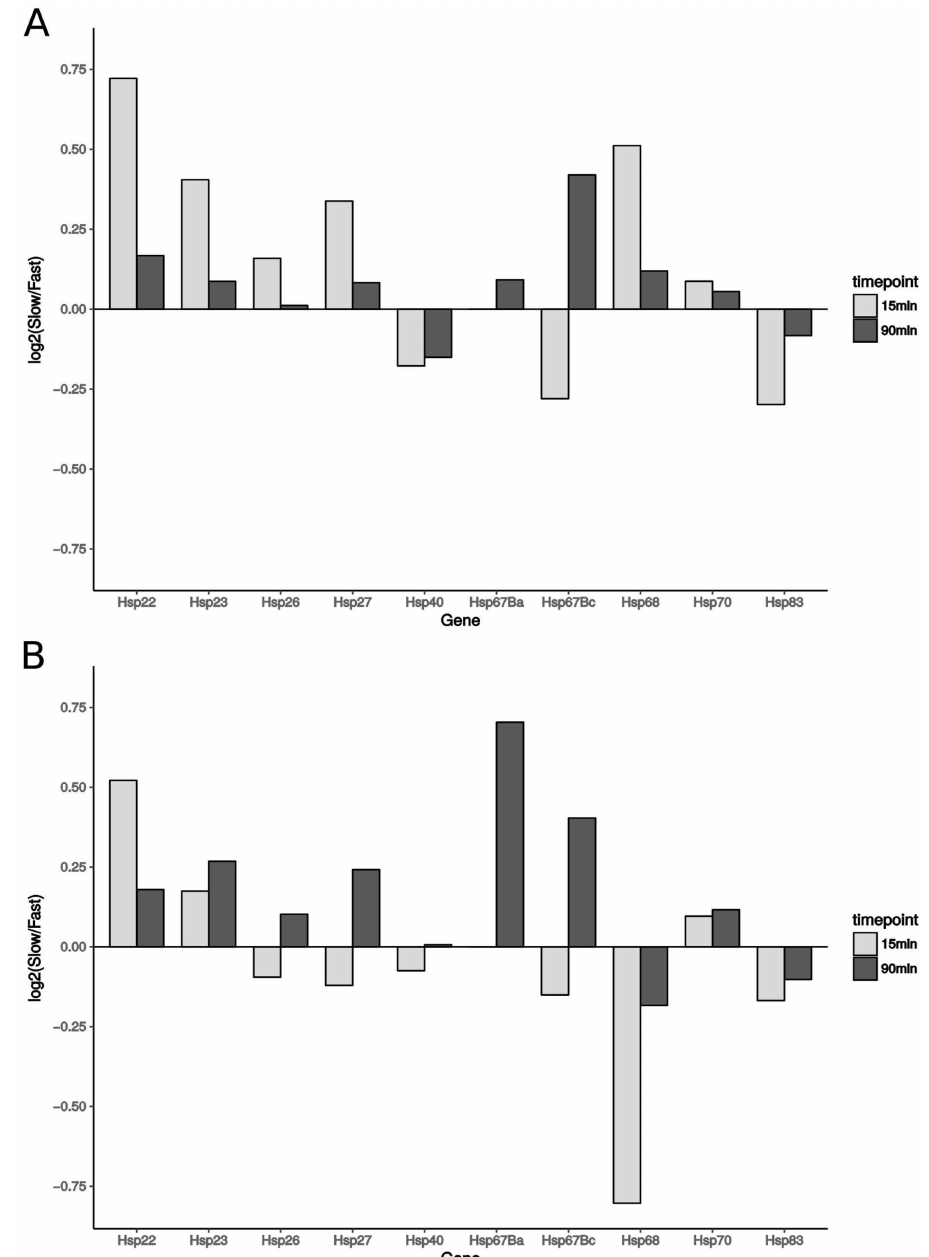
Figure 5. Comparison of transcriptional log2 fold changes of heat-shock proteins (Hsps) in cold-sensitive (slow CCR) and cold-tolerant (fast CCR) fly strains at 15 min (light bars) and 90 min (dark bars) in Drosophila ananassae ( A ) and Drosophila melanogaster ( B ). Bars represent the slow: fast log2 ratios of the log2 fold changes for each gene. A stronger transcriptional response in the cold-sensitive strains compared to the cold-tolerant strains can be seen as a positive bar, a stronger transcriptional response in the cold-tolerant strains compared to the cold-sensitive strains can be seen as a negative bar. Log2 fold changes for each gene and sample can be found in Additional File